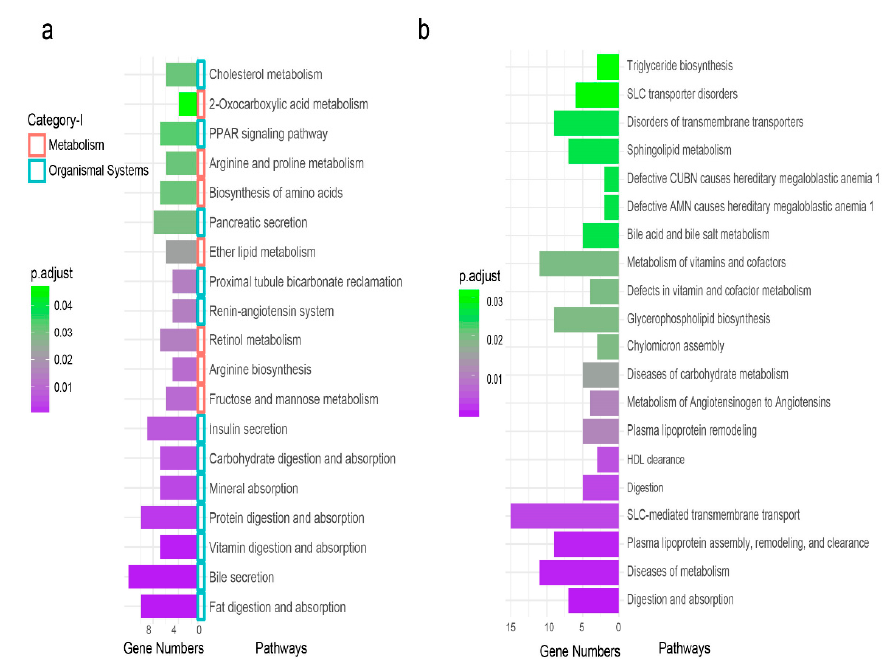
Figure 4. Pathway analyses of the DE genes. ( a ) Enriched pathways of the DE genes in the Kyoto Encyclopedia of Genes and Genomes (KEGG) pathway database. The vertical coordinates are the enriched pathways, and the horizontal coordinates are the number of DE genes in each enriched pathway. The color of the bar represents the adjusted p -value, while the small squares represent the pathway’s primary category. ( b ) Enriched pathways of the DE genes in the ReactomePA pathway database. The vertical coordinates are the enriched pathways, and the horizontal coordinates are the number of DE genes in each enriched pathway. The color of the bar represents the adjusted p